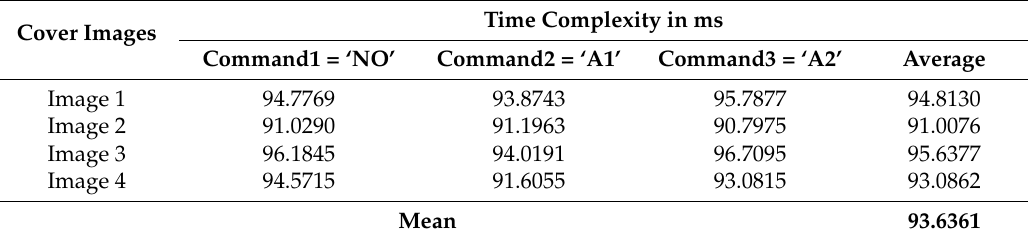
Table 6. Time complexity